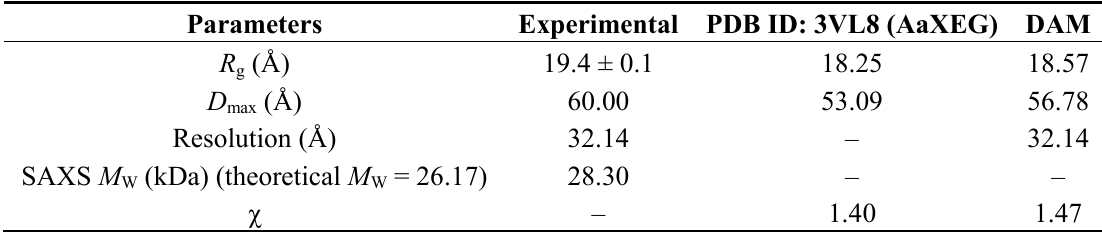
Table 1. GtCel12A and homologous AaXEG structural parameters.